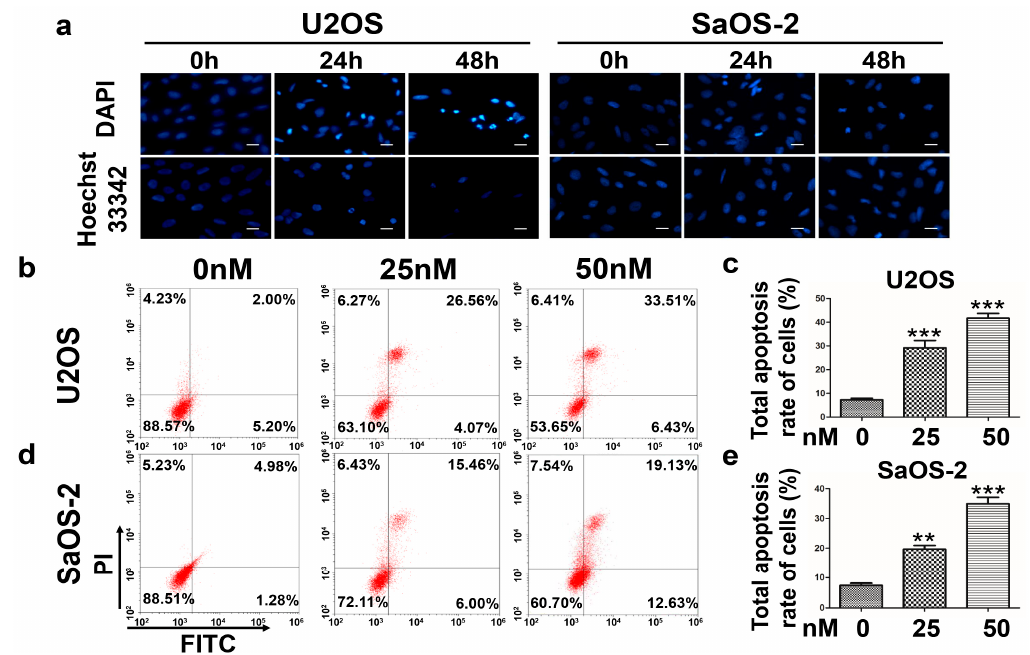
Figure 1. ( a ) DAPI and Hoechst staining of U2OS and SaOS-2 cells treated with different concentrations of oleandrin; Bar scale: 30 μ m; ( b ) The apoptosis of U2OS cells treated with different concentrations of oleandrin that detected by flow cytometry (FCM); ( c ) Statistical analysis of the total apoptosis rate of U2OS cells followed by FCM detection; n = 3, Mean ± SEM; ** p < 0.01, *** p < 0.001, vs . control (0 nM) group; ( d ) The apoptosis of SaOS-2 cells treated with different concentrations of oleandrin that detected by FCM; and ( e ) Statistical analysis of the total apoptosis rate of SaOS-2 cells followed by FCM detection; n = 3, Mean ± SEM; ** p < 0.01, *** p < 0.001, vs . control (0 nM) group.